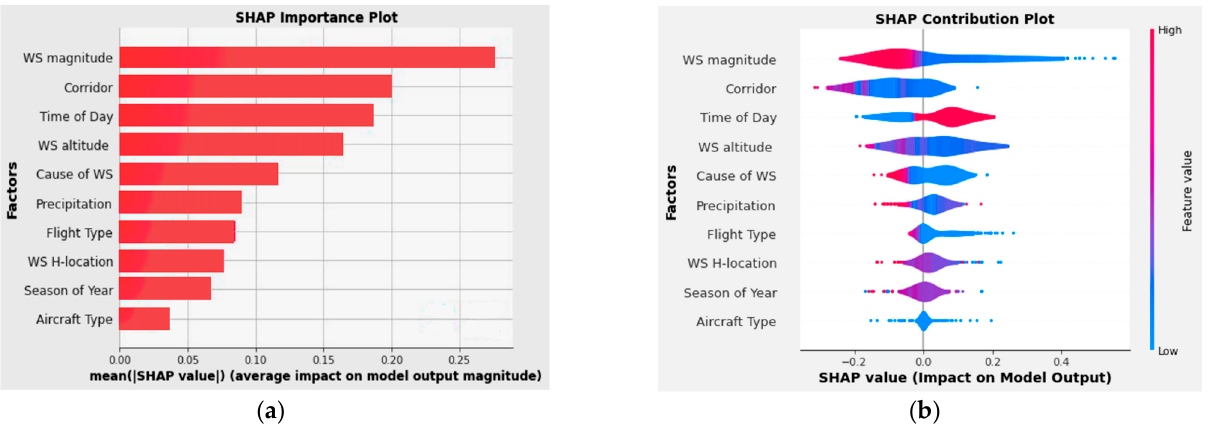
Figure 8. SHAP global interpretation: ( a ) SHAP importance plot and ( b ) SHAP beeswarm plot.